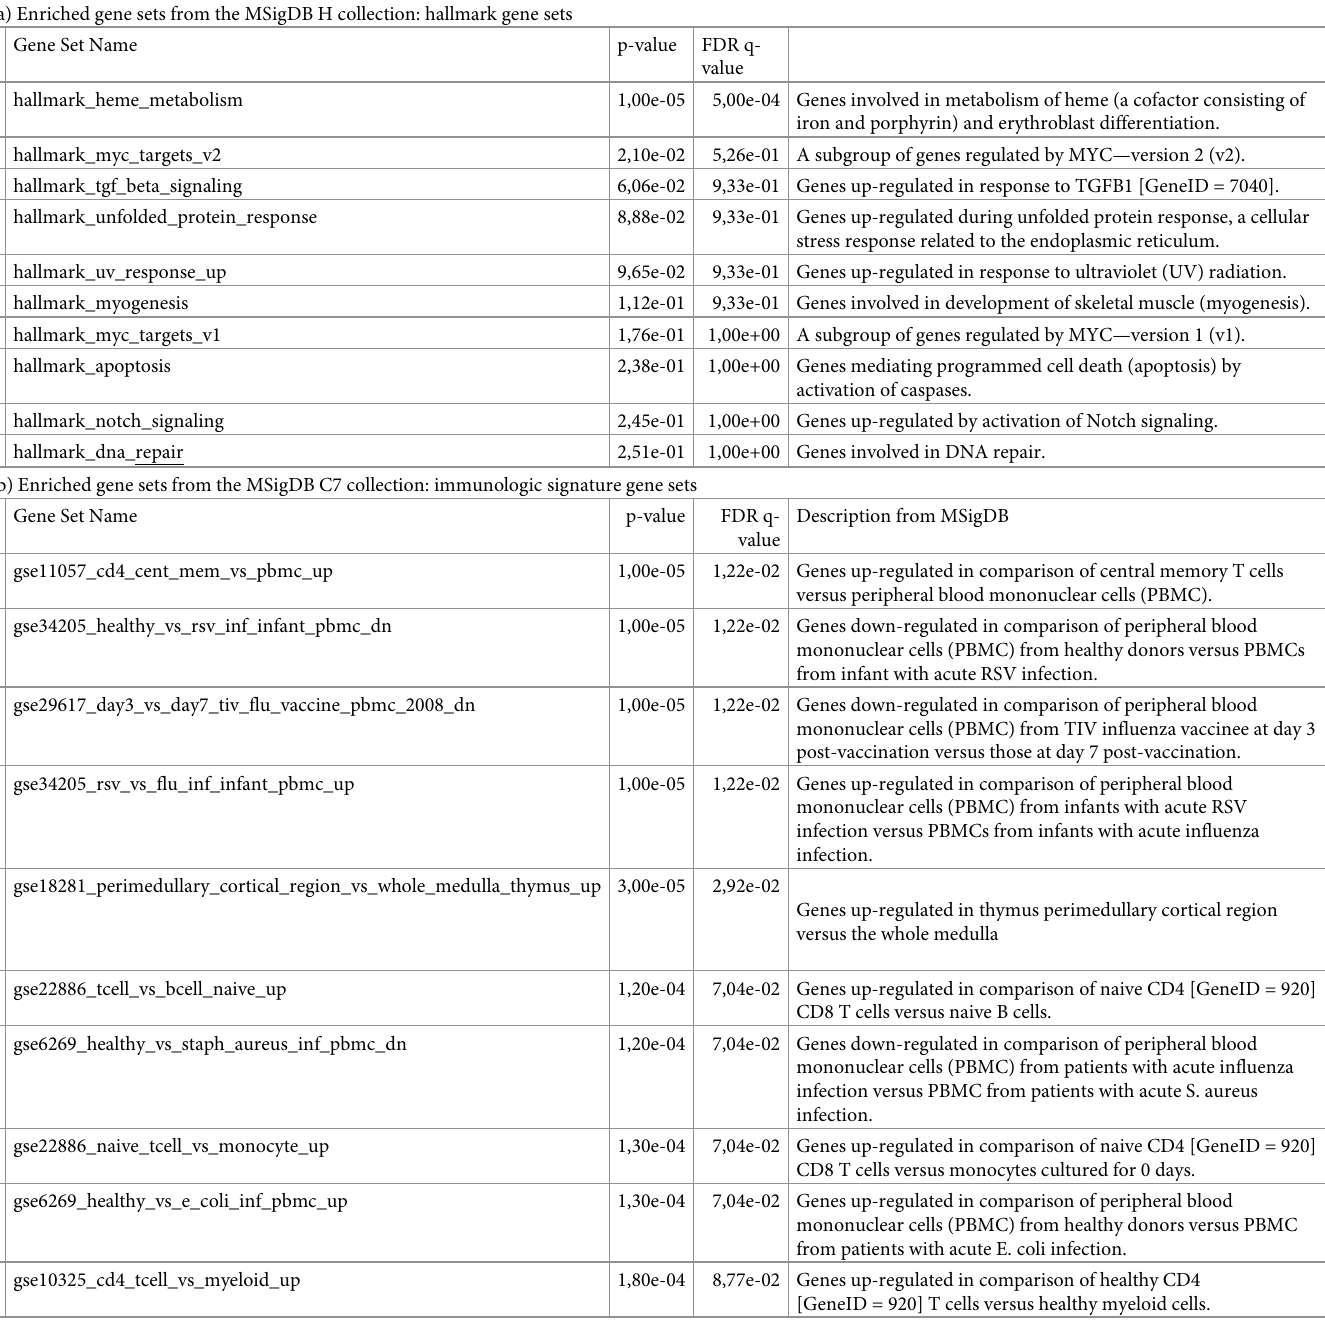
Table 4. Results from the fgsea analysis of enriched gene sets in blood gene expression profiles from metastatic cases who died during follow-up, compared to controls. a) Enriched gene sets from the MSigDB H collection: hallmark gene